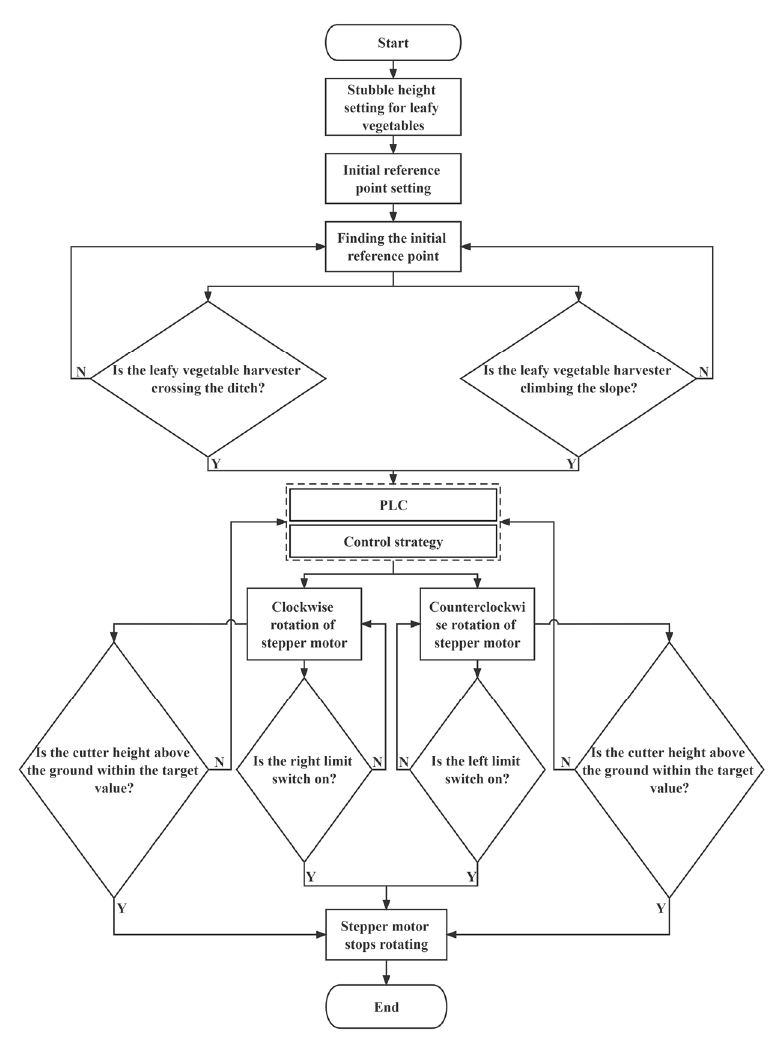
Figure 5. Flow chart of the automatic adjustment program of the cu tt er height o ff the